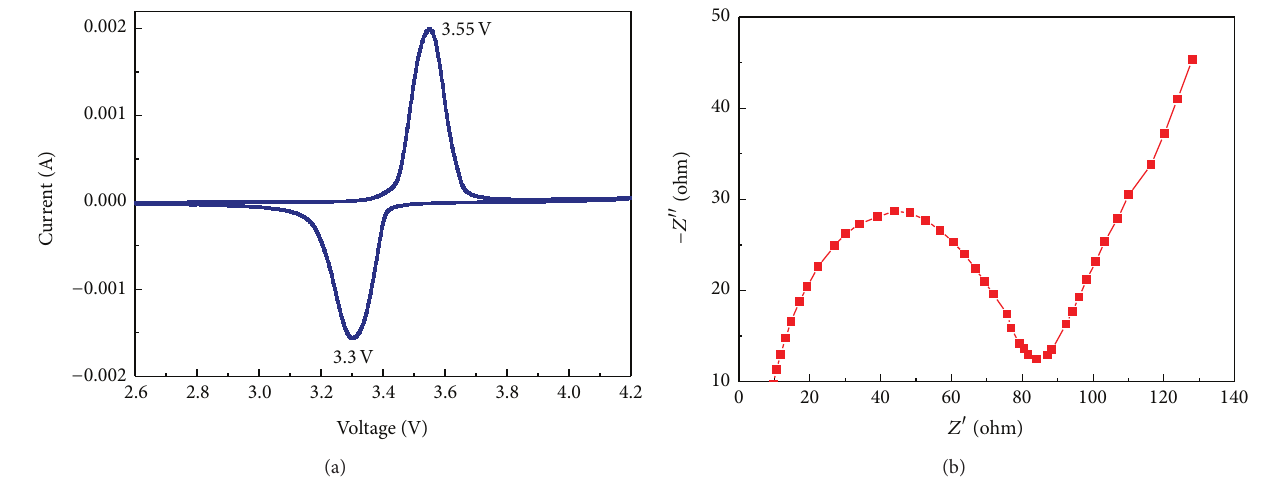
Figure 7: The cyclic voltammogram curves and EIS